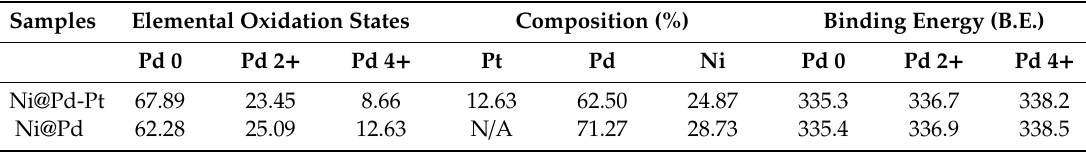
Figure 3. X-ray photoelectron spectroscopy of ( a ) Ni@Pd-Pt and ( b ) Ni@Pd NCs at Pd-3d orbitals. Table 1. The elemental oxidation states, composition ratios and binding energies of Ni@Pd-Pt compared with Ni@Pd NC.